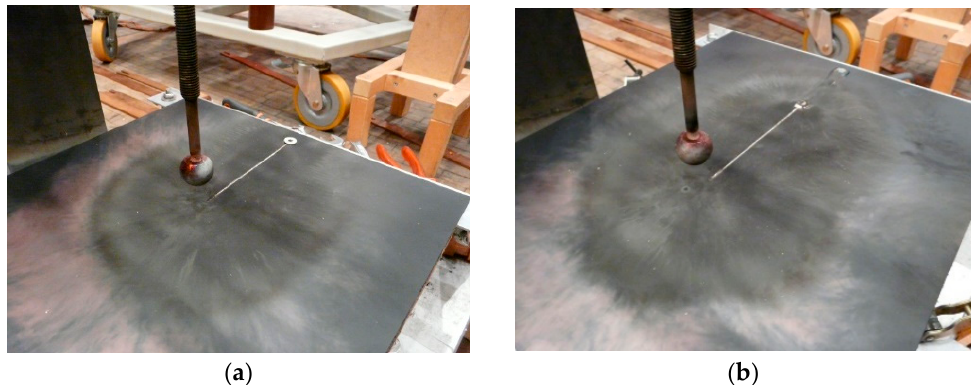
Figure 12. ( a ) Front side of sample C1-B (segmented diverter strip) after the first test current (component A), and ( b ) front side of the sample C2-B (combination of solid and segmented diverter strip) after the second test current (component A).